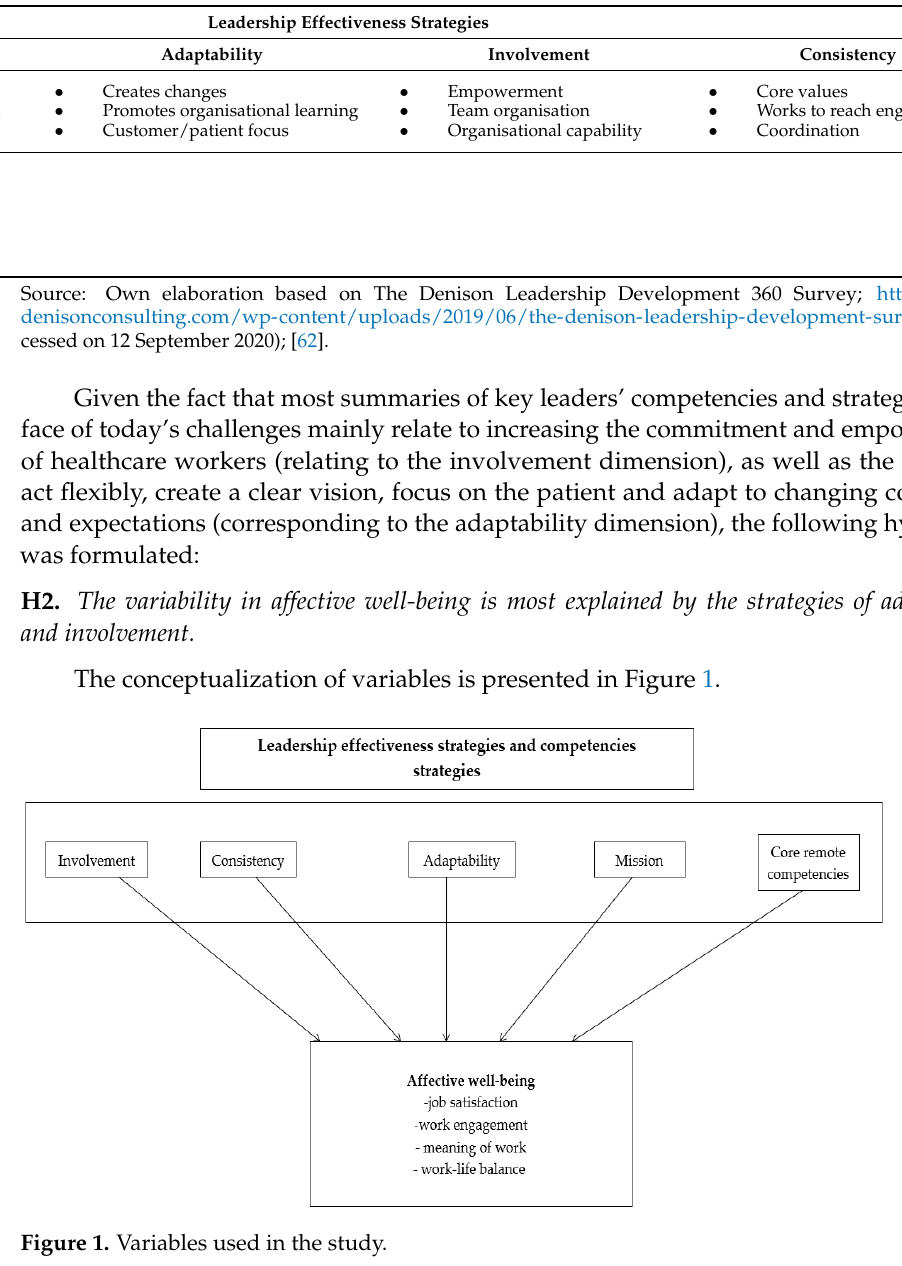
Table 1. Leadership effectiveness strategies and core remote competencies.